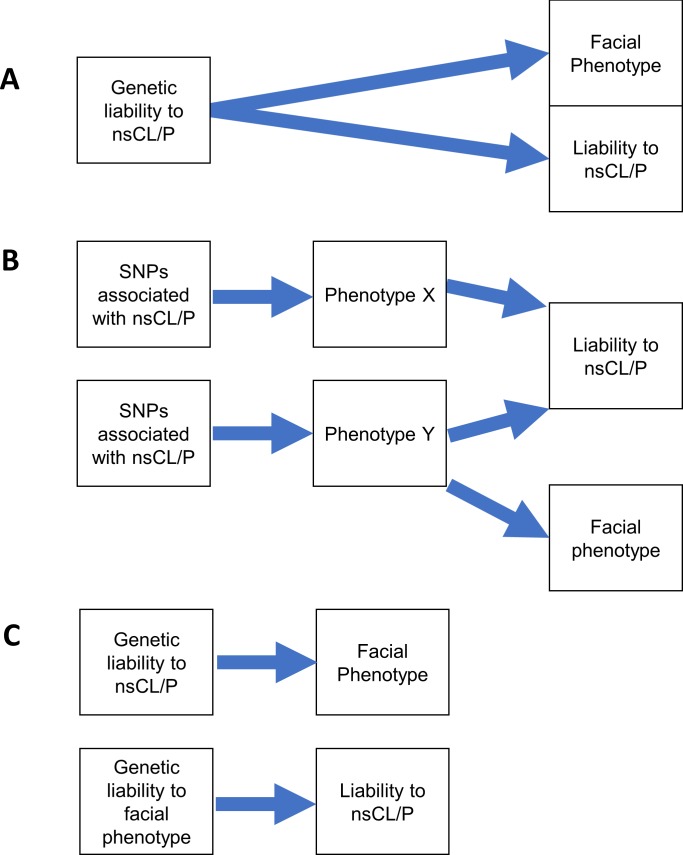
Interpretation of bidirectional MR.(A) SNPs associated with nsCL/P have a homogeneous effect on the facial phenotype with weak evidence for the reverse direction MR. We would conclude that genetic liability to nsCL/P causes both increased liability to nsCL/P (in conjunction with the environment and chance) and changes in the facial phenotype. (B) SNPs associated with nsCL/P have a heterogeneous effect on the facial phenotype. In this instance, there is weak evidence for genetic liability to nsCL/P causing changes in the facial phenotype because liability assumes a consistent effect. We would conclude that an unknown confounder Y affects the facial phenotype and liability to nsCL/P independently. (C) SNPs associated with nsCL/P have a homogeneous effect on the facial phenotype AND SNPs associated with the facial phenotype cause increased liability to nsCL/P. In this instance, there are two possibilities. The first possibility is that the genetic instruments for the facial phenotype are weak (e.g. only one SNP) and so the causal effect estimate of the facial phenotype on liability to nsCL/P is imprecise. The second possibility is that nsCL/P and the facial phenotype have a substantial genetic correlation, which would require further investigation. Here, the results of the Steiger test are useful, as they can infer the most likely direction of effect between nsCL/P and implicated facial phenotypes.